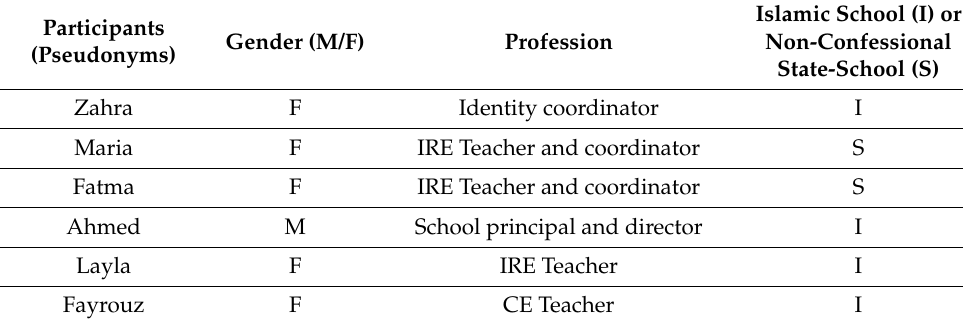
Table 2. Characteristics of participants focus group 2 (N =